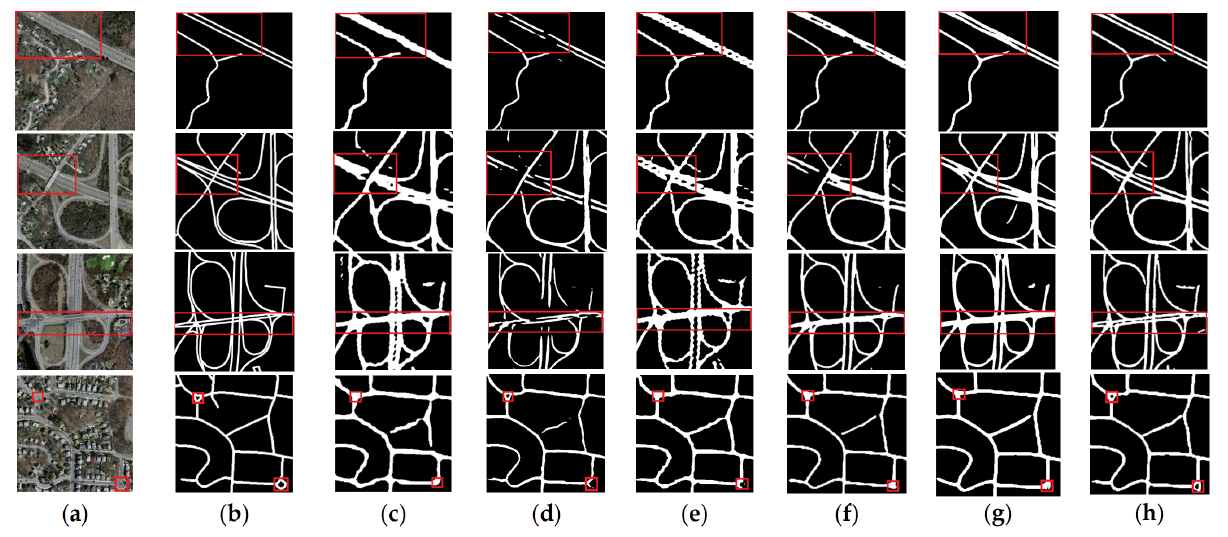
Figure 6. Results of MSPFE ‐ Net and other methods. ( a ) Image; ( b ) Label; ( c ) DeepLabv3+; ( d ) U ‐ Net; ( e ) HRNetV2; ( f ) D ‐ LinkNet; ( g ) RefineNet ( h ) MSPFE ‐ Net.( Red squares represent key areas. )